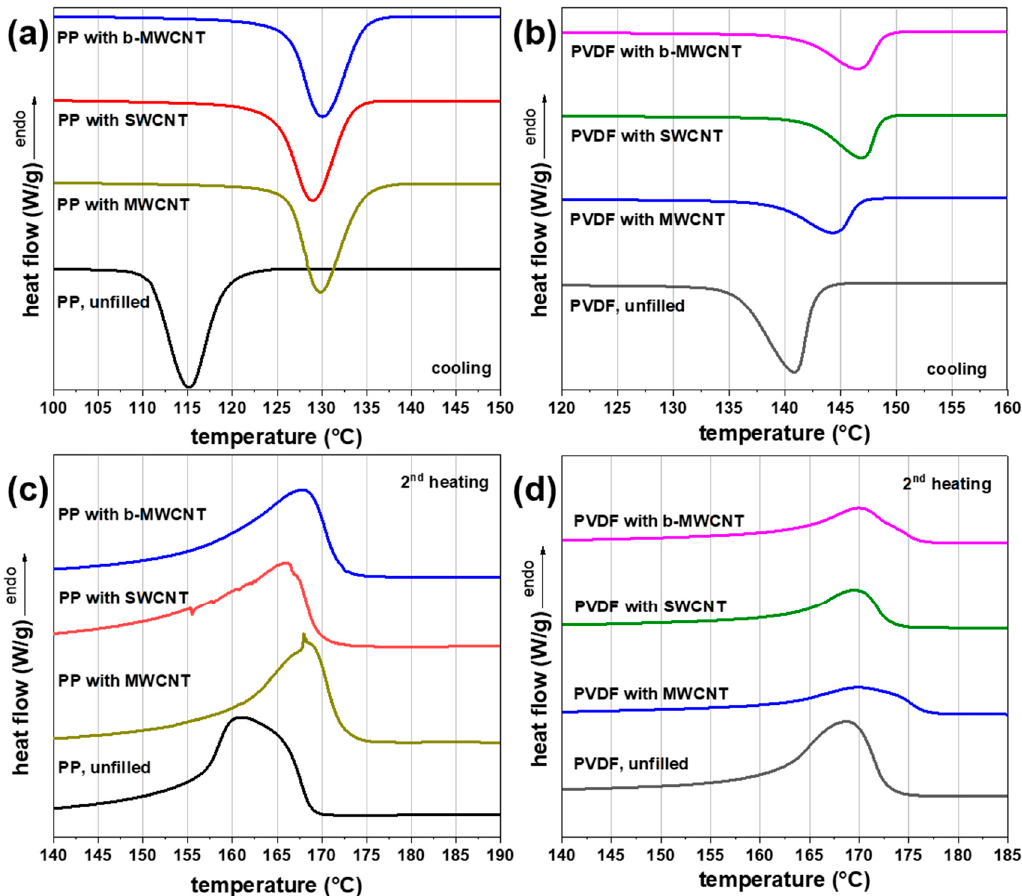
Figure 6. Differential scanning calorimetry (DSC) cooling cycles for PP and PVDF based composites ( a , b ), DSC heating cycles for PP and PVDF based composites ( c , d ). All composites contain 2 wt % CNTs.